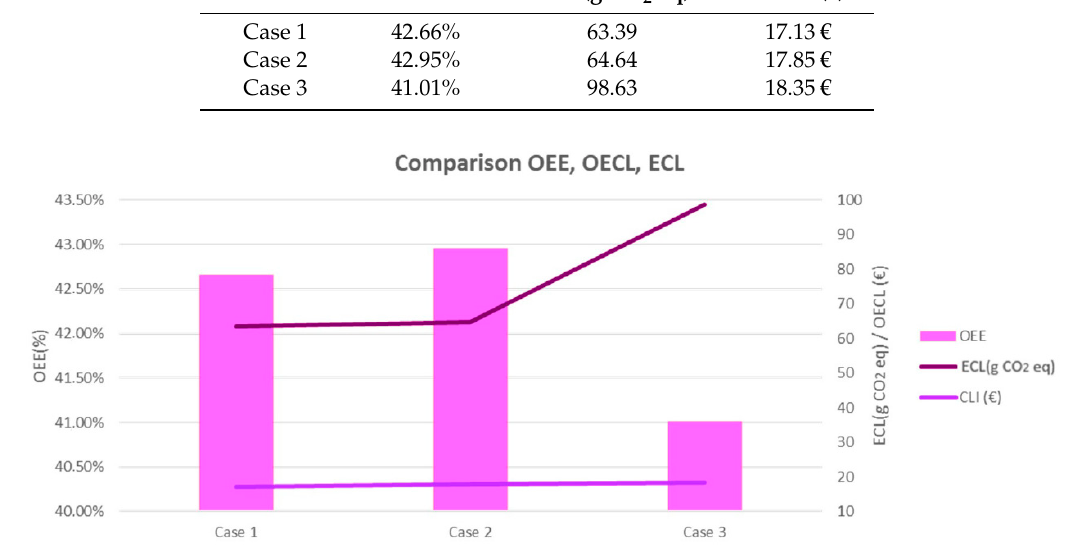
Figure 10. Comparison between OEE, ECL, and new KPI.